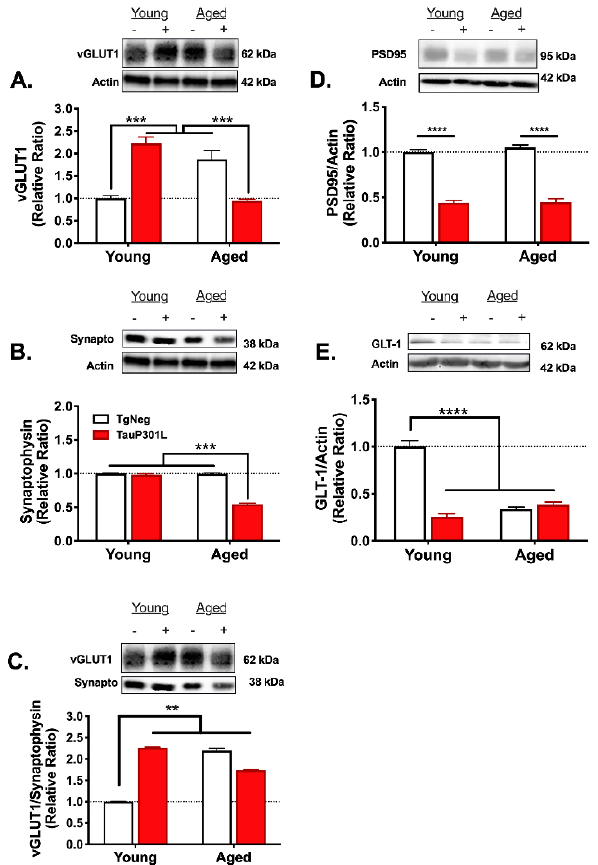
Figure 5. Age- and tau-associated alterations in the tripartite synapse. Age and P301L tau expression resulted in alterations in vGLUT1 ( A ), synaptophysin ( B ), vGLUT1/synaptophysin ( C ) PSD-95 ( D ), and GLT-1 expression ( E ). ** p < 0.01; *** p < 0 .001; **** p < 0 .0001; n = 7 – 9/group. − represents TgNeg and + represents P301L.